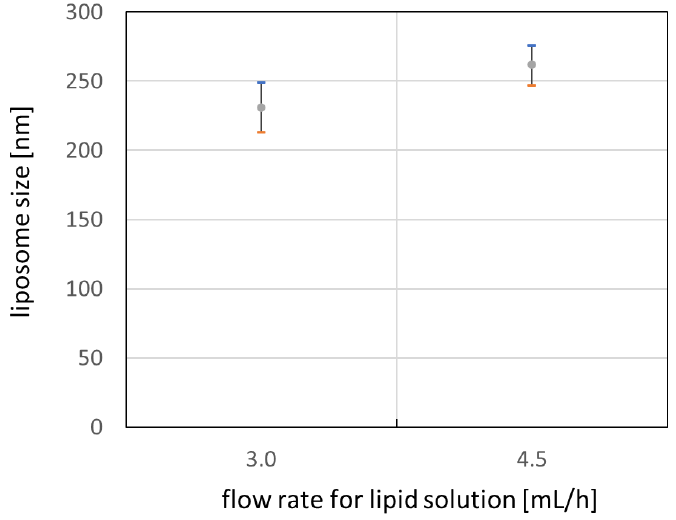
Figure 15. Liposome size depending on flow rate for lipid solution.